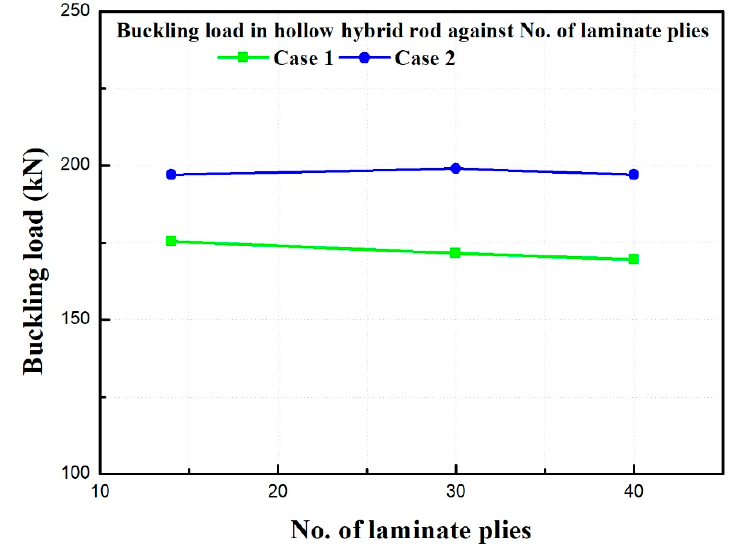
Figure 15. Variation of buckling load as a function of the number of laminates in CFRP.